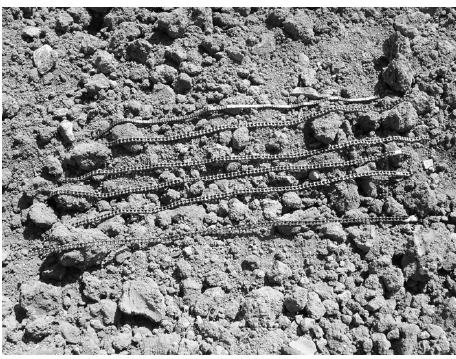
Fig. 4. Chain set used to measure soil surface roughness on soil that has been tilled with a chisel.